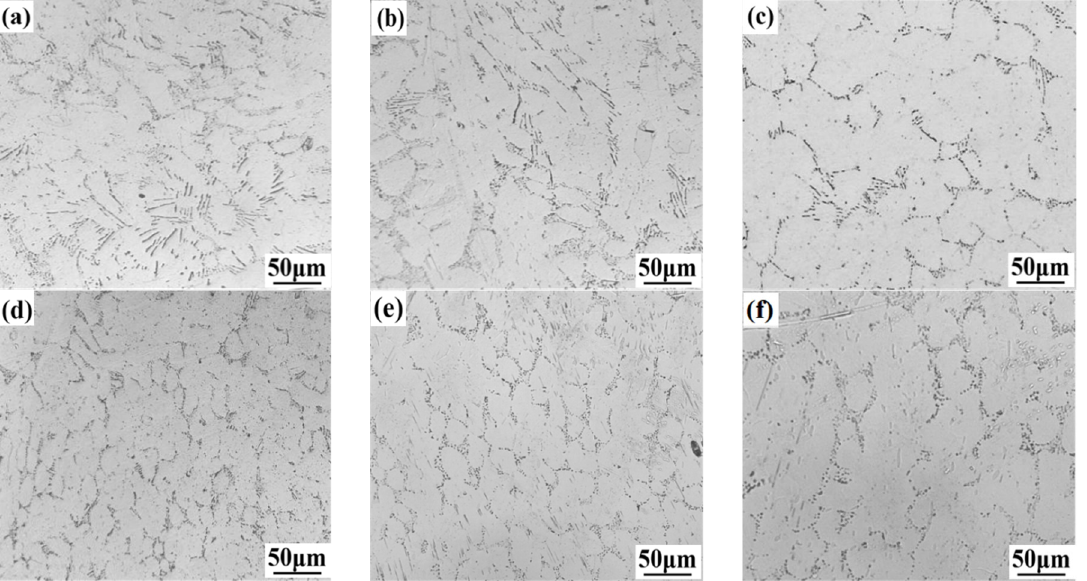
Figure 3. Microstructure images of SAC105/Cu: ( a – c ) and SAC105-(nano)Al 2 O 3 /Cu: ( d – f ) subjected to 100 cycle: ( a , d ); 400 cycle: ( b , e ); 1000 cycle: ( c , f